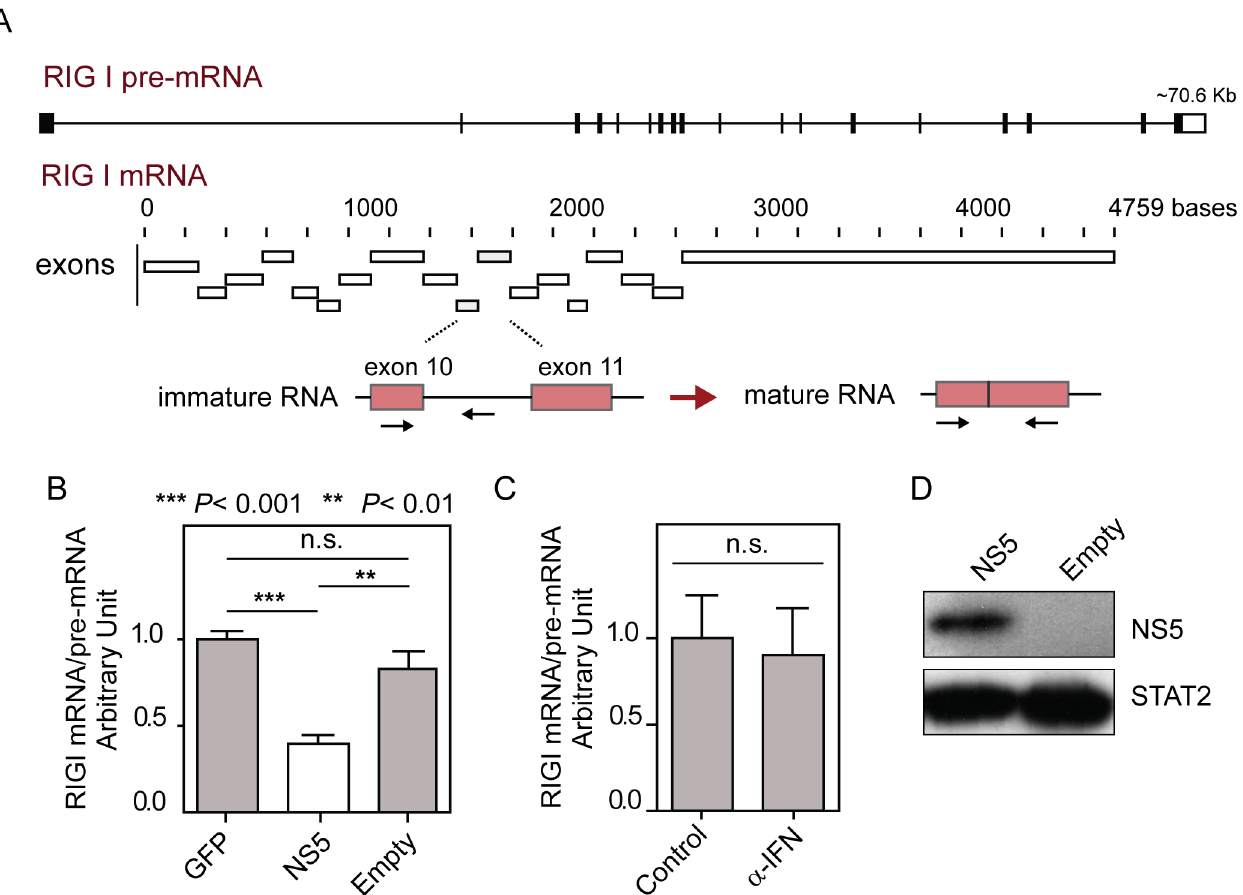
Fig 7. NS5 reduces the splicing efficiency of endogenous RIG-I mRNA. (A) Schematic representation of RIG-I pre-mRNA and mRNA. The abundance of these forms was measured by quantifying the immature and mature RNA transcripts using the region corresponding to exon 10, exon 11 and the intron between them, as indicated. The relative positions of the primers designed for RT-qPCR are depicted. (B) NS5 expressed as a mature protein significantly reduces the RIG-I splicing efficiency compared with GFP or an empty vector control. Data corresponding to four independent experiments is shown, mean ± SD. (C) RIG-I splicing efficiency (estimated as the RIG-I mRNA/pre-mRNA ratio) was not altered by α -IFN. (D) NS5 expressed as a mature protein does not induce STAT2 protein